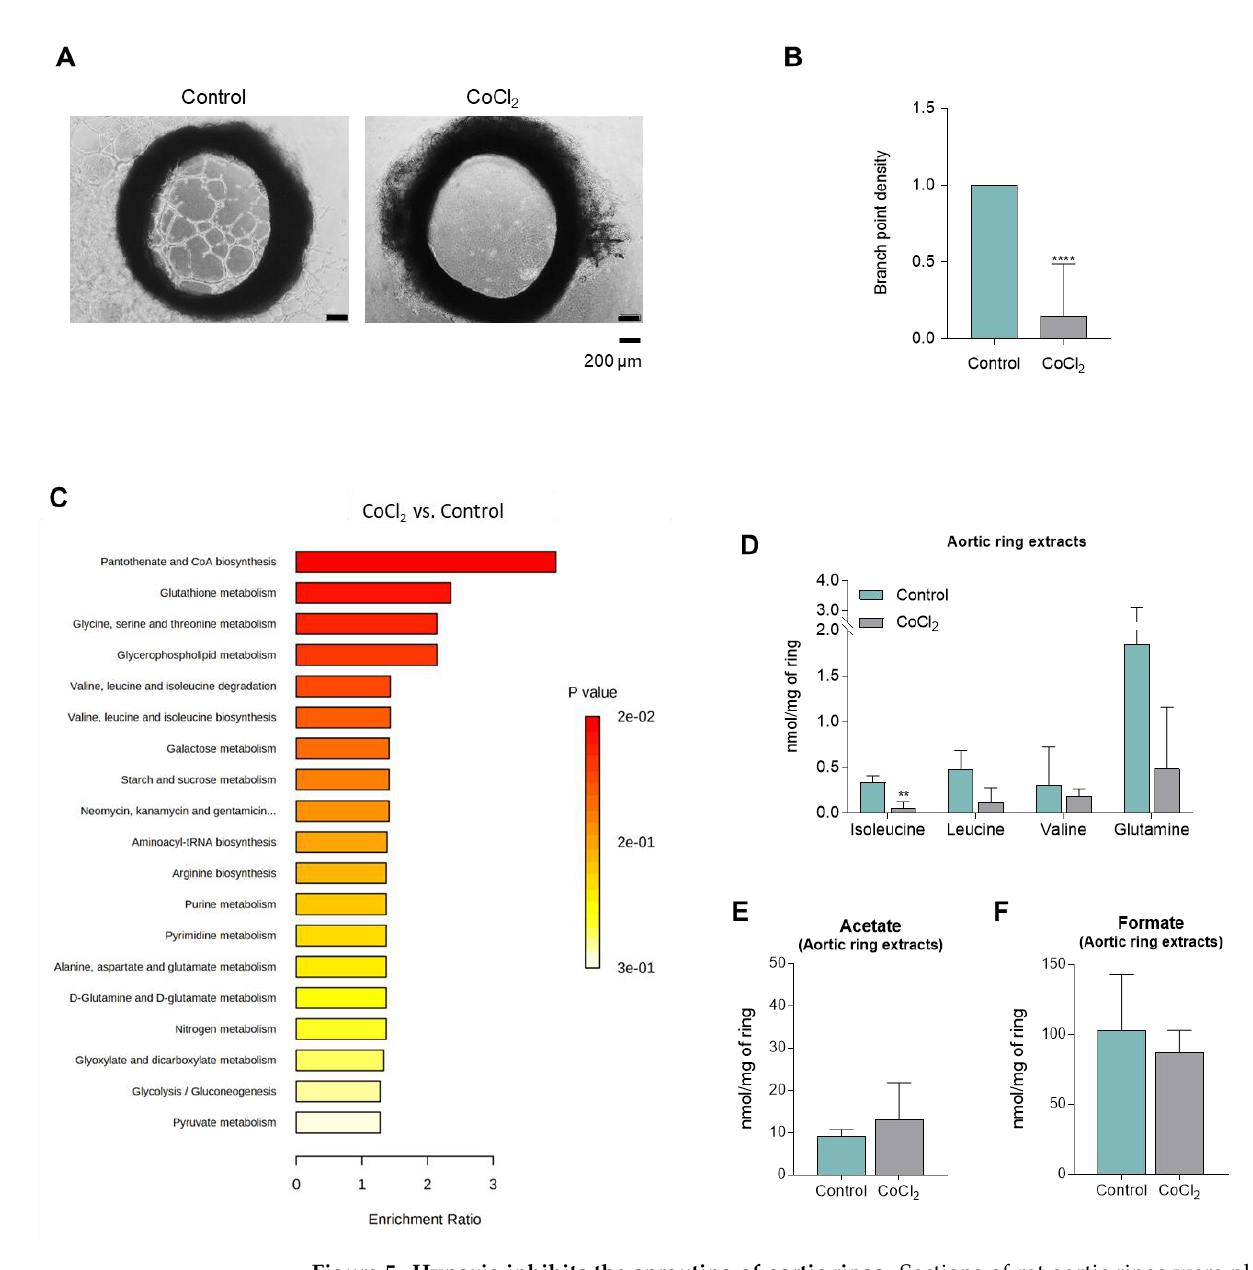
Figure 5. Hypoxia inhibits the sprouting of aortic rings . Sections of rat aortic rings were plated in Matrigel and cultured in basal culture condition (control) and in hypoxia-mimicked condition (200 μM CoCl 2 ). Aortic rings’ endothelial cell sprouting was followed for 10 days. Aortic rings were collected, cell extracts were performed, and cell culture media (supernatants) were collected for nuclear magnetic resonance (NMR) spectroscopy analysis. ( A ) Representative images of aortic rings at day 10 (40×, scale: 200 μm). ( B ) Sprouting quantification: number of branch points per sprout area (areas around and inside the ring were sprouting and visible), normalized to the control. ( C ) Enrichment analysis of pathways overexpressed when aortic rings were exposed to CoCl 2 . ( D ) Metabolite concentration of BCAAs (isoleucine and leucine), valine, and glutamine of extracts of aortic rings exposed to CoCl 2 . ( E ) Acetate levels in aortic ring extracts. ( F ) Formate levels in aortic ring extracts. Results are represented as mean ± SD. ** p < 0.01, **** p < 0.0001; unpaired t- test (two-tailed) . 3.5. Different Metabolic Profiles Correspond to the Activation of Endothelial Cell, the Sprouting of Aortic Ring Induced by ROS, and the Inhibition by Propranolol In order to find if the proangiogenic impact of ROS and the antiangiogenic effect of propranolol in endothelial cell functioning would correspond to different metabolic